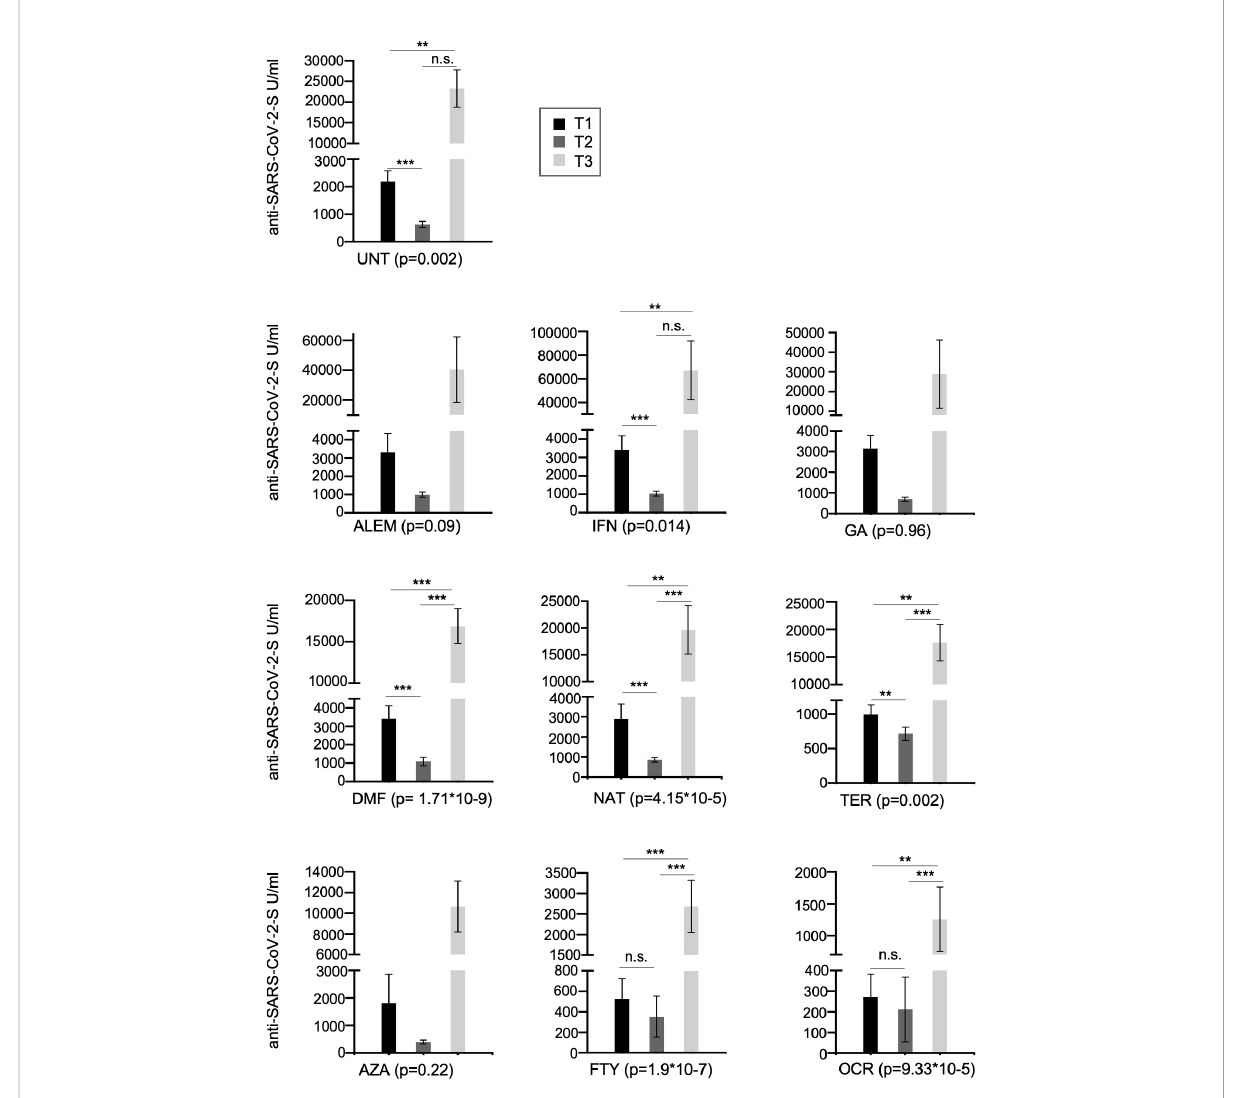
FIGURE 3 Cross-sectional humoral response over time (T1, T2 and T3) in all the MS patients treated with different DMTs or untreated. Post-vaccination anti-S antibody response by disease- modifying therapy (DMT) in MS patients. Results are represented as histogram showing the median value. Signi fi cance was tested using Mann-Whitney test. (**P<0.01; ***<0.001). (UNT, untreated; ALEM, alemtuzumab; IFN, interferon; GA, glatiramer acetate; DMF, dimethyl fumarate; NAT, natalizumab; CLA,cladribine; TER, teri fl uomide; AZA, azathioprine; FTY, fi ngolimod; RTX, rituximab; OCR, ocrelizumab). n.s. indicate not signi fi